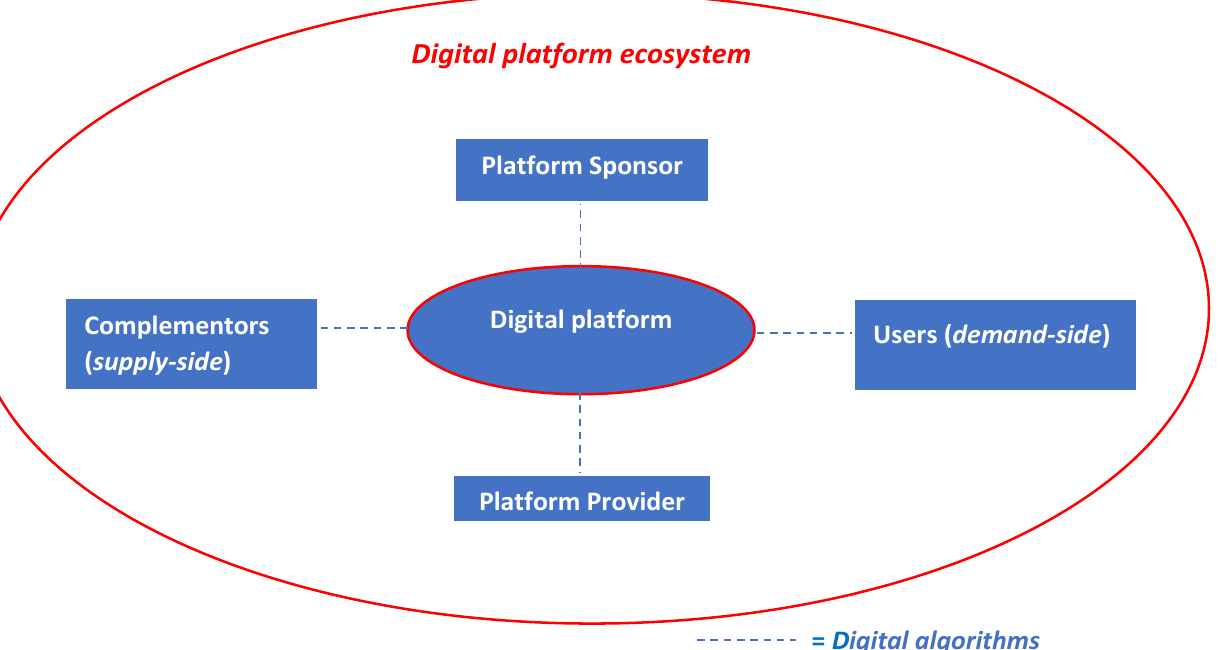
Figure 1. The digital platform ecosystem. Source: authors’ elaboration.